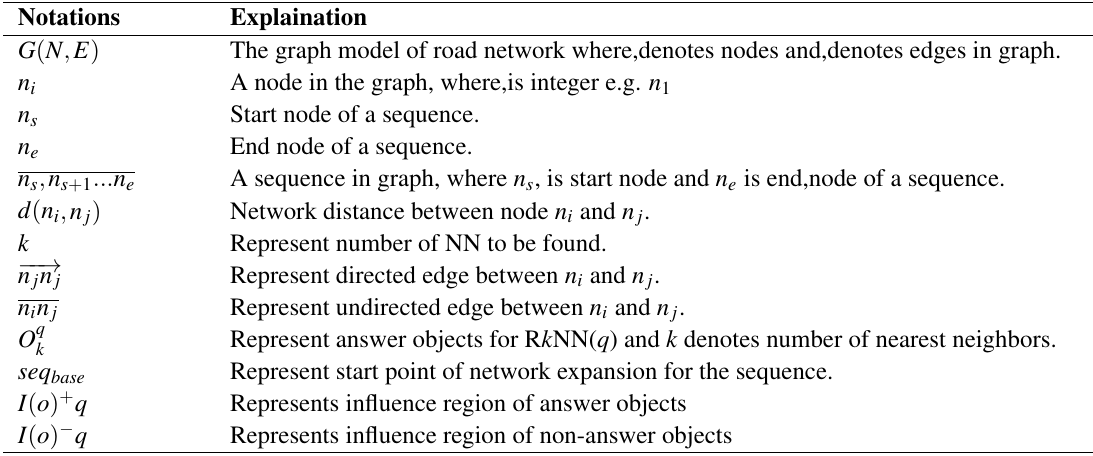
Table 1. Summary of Notations